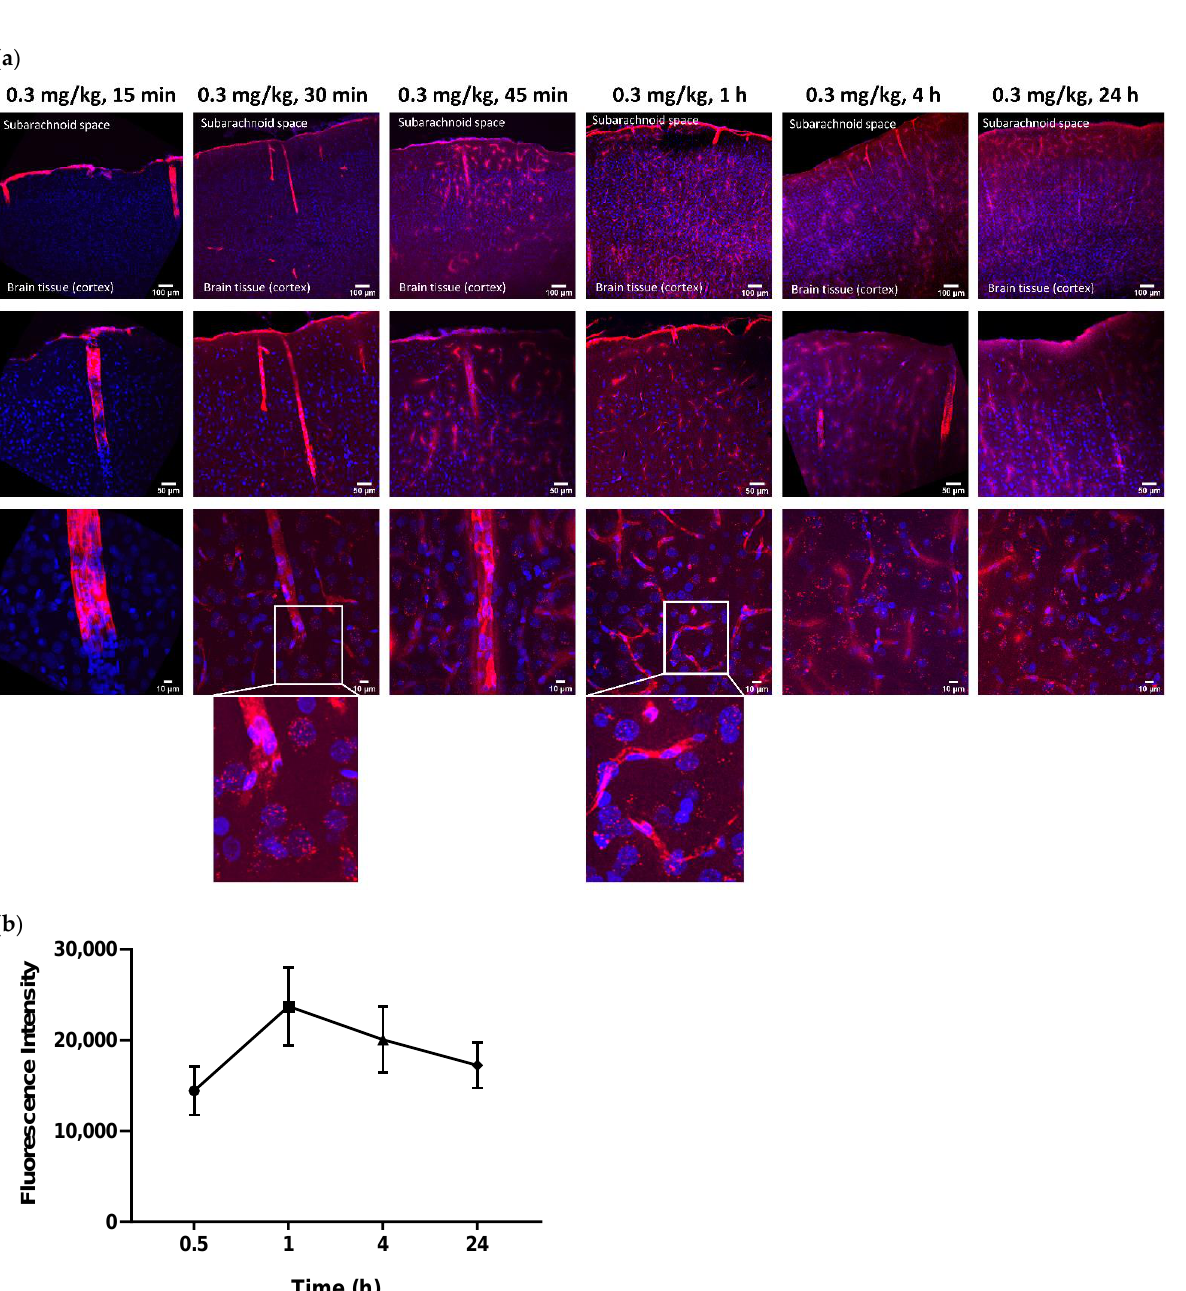
Figure 1. Intra-Cerebrospinal Fluid (CSF) Cortical Biodistribution Data. The parent IgG1 antibody penetrated the brain parenchyma within 30 min of administration into the rat cisterna magna. Rep- resentative images. ( a ) Within 15 min post-injection, at a dose of 0.3 mg/kg, intra-CSF administered ABT-806 could only be seen along the periarteriolar spaces with no tissue penetration. After 30 min, the parent antibody started penetrating the brain parenchyma via the periarteriolar spaces. More penetration was observed after 45 min and 60 min of administration with ABT-806 starting to clear out of the parenchyma via the perivenular spaces. The parent antibody continued to enter the pa- renchyma even after 4 h post-injection. After 24 h, ABT-806 was still present in the tissue. Blue = 4′,6 -diamidino-2-phenylindole (DAPI), Red = ABT-806. ( b ) Quantification of the fluorescence intensity in the parenchyma but excluding the vasculature, indicates highest antibody concentrations at 1 h post-injection. 0.5 h: 14,437 ± 2655; 1 h: 23,750 ± 4280; 4 h: 20,063 ± 3635; 24 h: 17,245 ± 2514. p > 0.05. n = 3 animals per timepoint, average of 20–25 slices per animal per